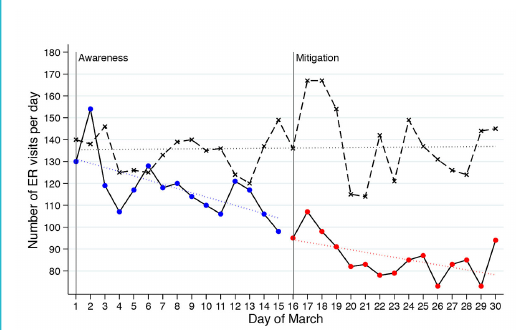
Figure 1: Total number of patients per day during different phases of the COVID-19 pandemic in March 2020 compared to the control group in March 2019. A linear fit of each scatter plot is shown in dotted